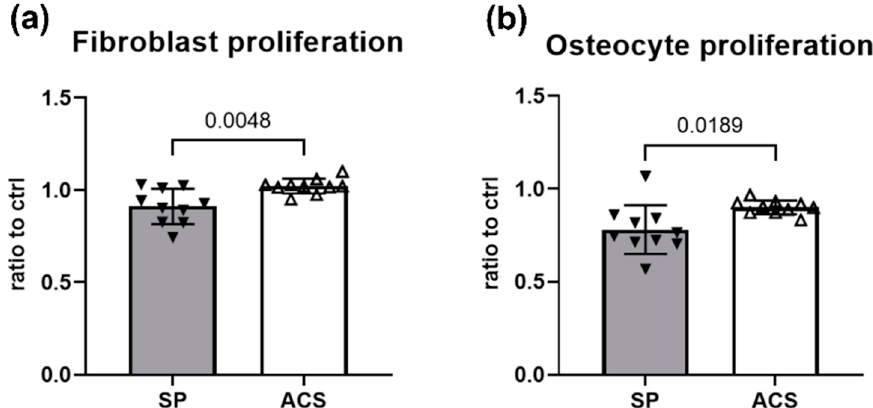
Figure 5. Regenerative property of ACS in promoting fibroblast and osteocyte proliferations. Bar graphs show the cell proliferation ratios using the MTS assay. Error bars depict means with SDs in all panels. The ACS effects on ( a ) fibroblast and ( b ) osteocyte proliferations were shown. Y -axis indicates the normalized values ratio to control medium culture. Statistical differences were calculated using a two-tailed paired sample t -test. Filled and blank triangles are representatives of the mean results obtained from 10 OA dogs, three independent experiments for each cell line and technical triplicates for each round. Abbreviations, ACS; Autologous conditioned serum, SP; Sham plasma, Ctrl; Control (cells grown in the standard complete media recommended for each type of cell line).